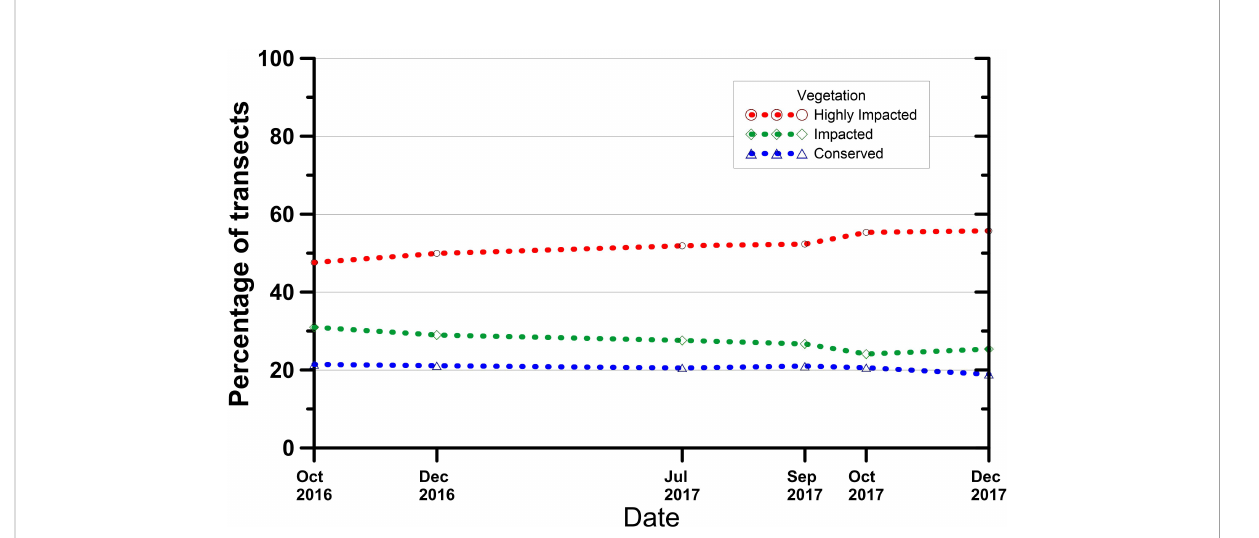
FIGURE 5 Progression of the vegetation coverage expressed in percentage of transects for the three different categories along the 14 months of study. In dotted red line the Highly Impacted class, in dotted green line the Impacted class and in dotted blue line the Conserved class.